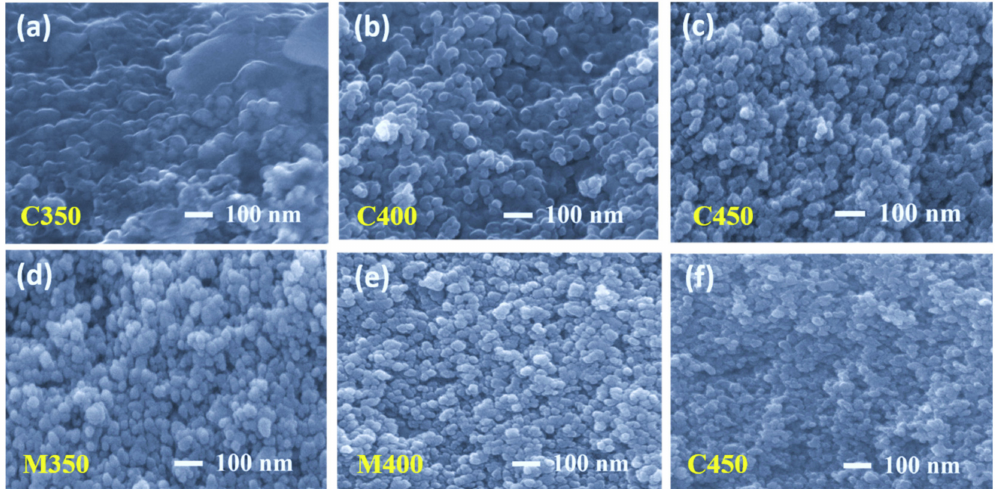
Figure 4. High-resolution fractography images of ( a – c ) Conventionally sintered titania films and ( d – f ) Microwave sintered titania